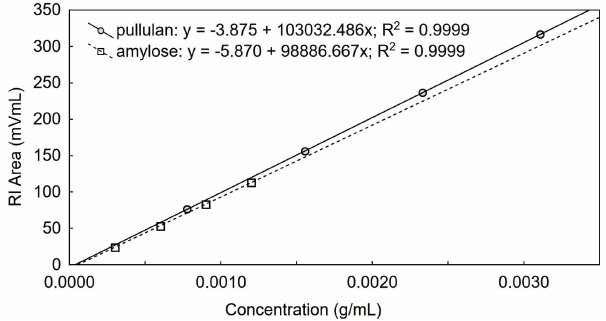
Figure 2. Chromatographic RI data used for the determination of dn / dc of pullulan and amylose from potato in 50 mM phosphate bu ff er (pH 8.0) with 100 mM urea, V inj = 100 µ L.